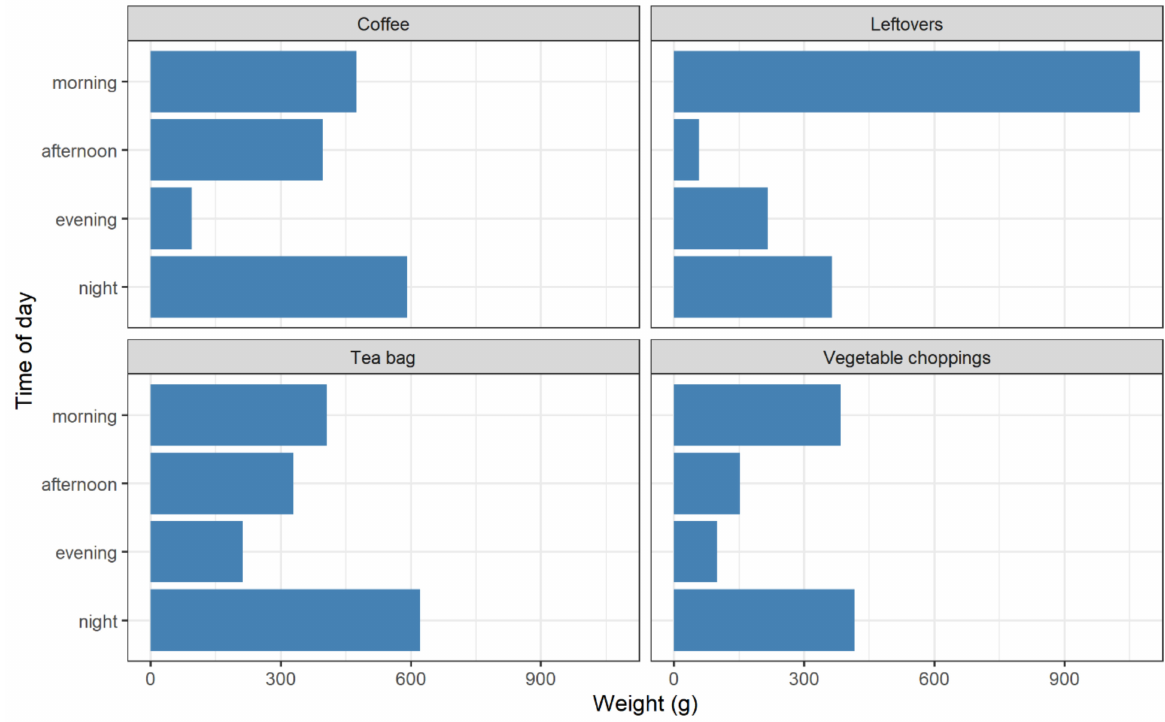
Figure 10. Total weight of selected waste items and time of